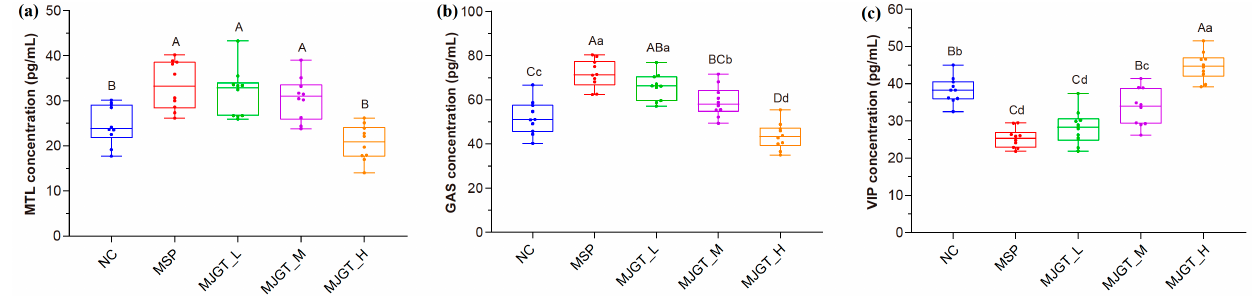
Figure 2. Effects of different concentrations of MJGT hydro extracts on the secretion of MTL ( a ), GAS ( b ) and VIP ( c ) in rat serum after 30 d administration. n = 10 for each group. Capital and lowercase letters above the bar indicate the difference significance at 0.01 or 0.05 level, respectively.